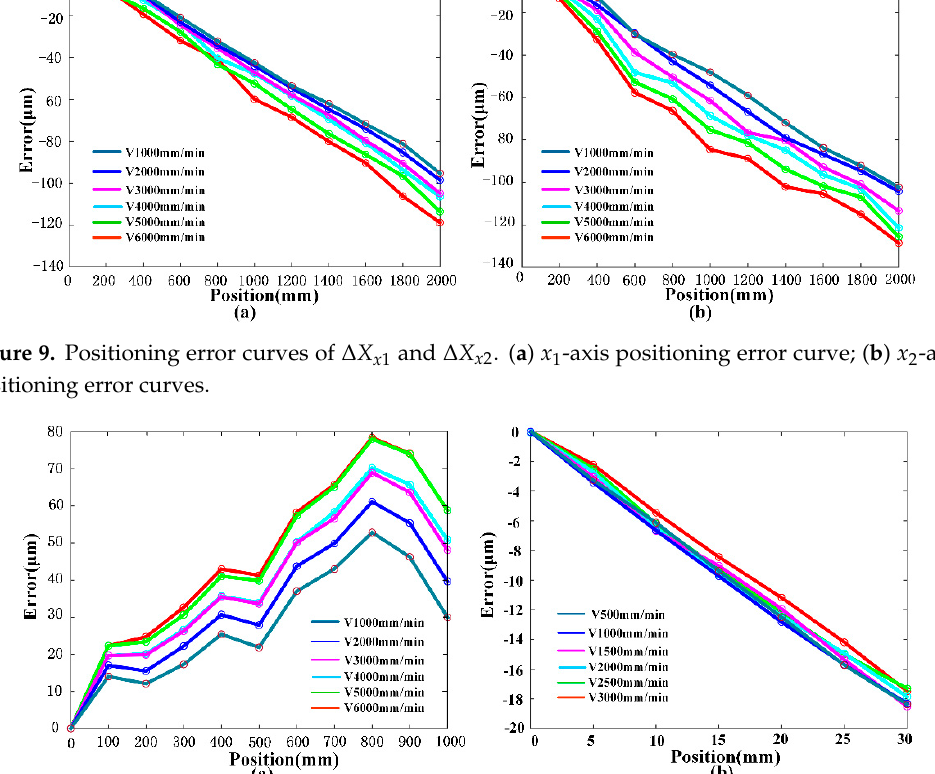
Figure 10. Positioning error curves of ∆ Y y and ∆ Z z , ( a ) y -axis positioning error curves ( b ) z -axis positioning error curves.